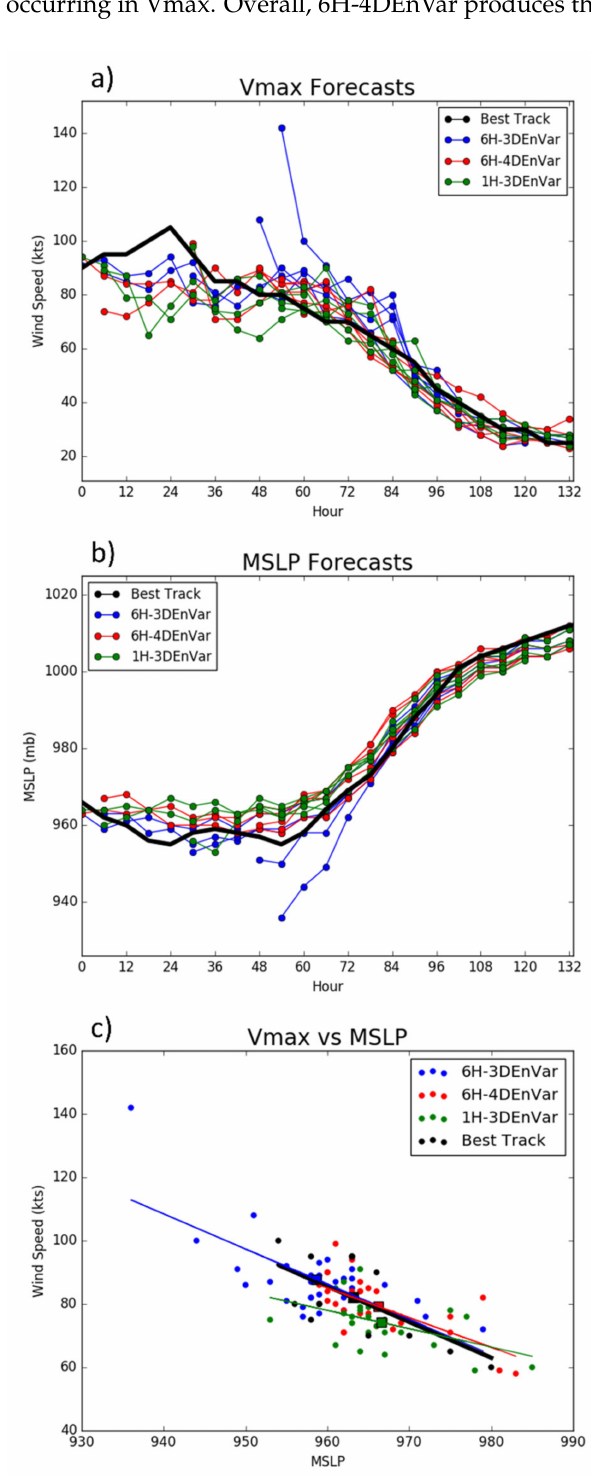
Figure 3. ( a ) Vmax and ( b ) MSLP Forecasts plotted over Best track. Hour is hours from 1200 UTC 15 September. Scatter plot of ( c ) Vmax vs. MSLP plotted over Best track. Red is 6H-4DEnVar, blue is 6H-3DEnVar, green is 1H-3DEnVar, and black is best track. Squares represent the mean of each experiment and lines are the slope. p = 0.17 for difference of 1H-3DEnVar and Best track